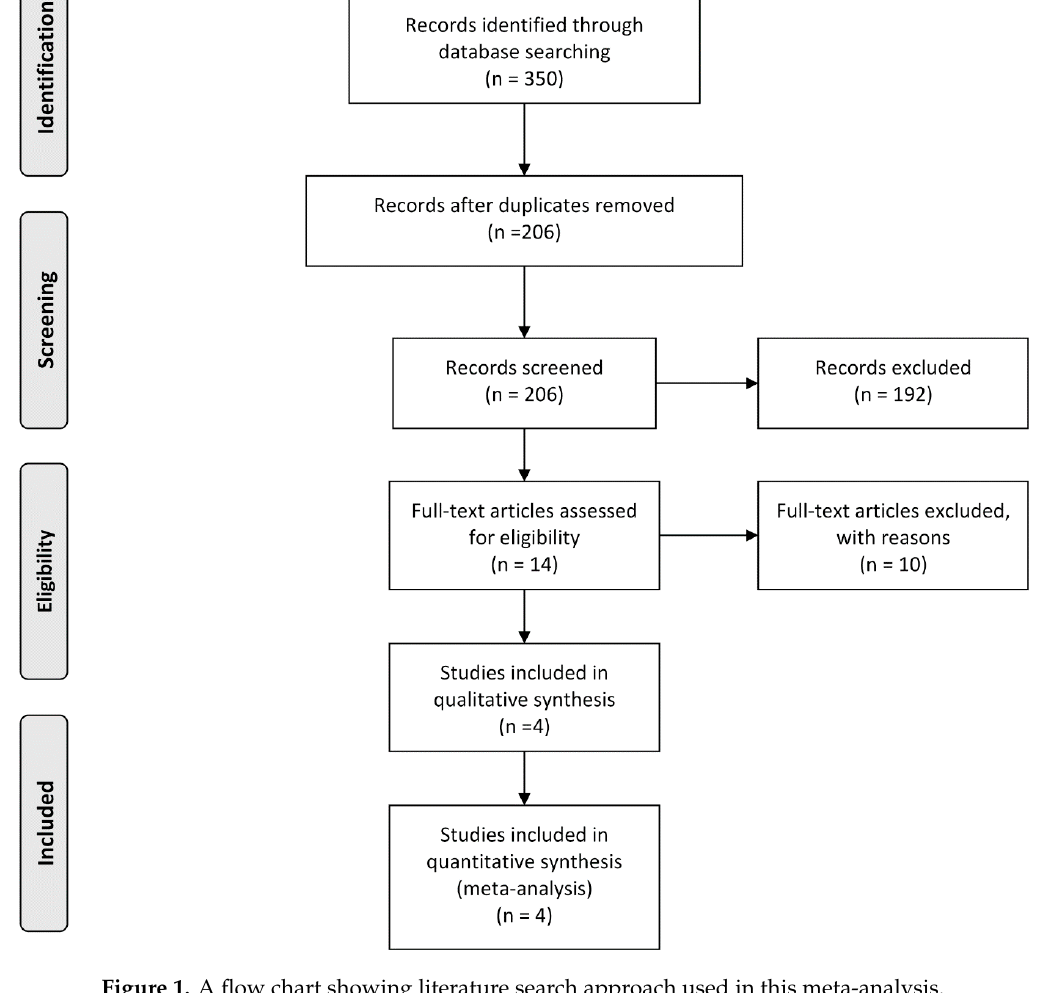
Figure 1. A flow chart showing literature search approach used in this meta-analysis.